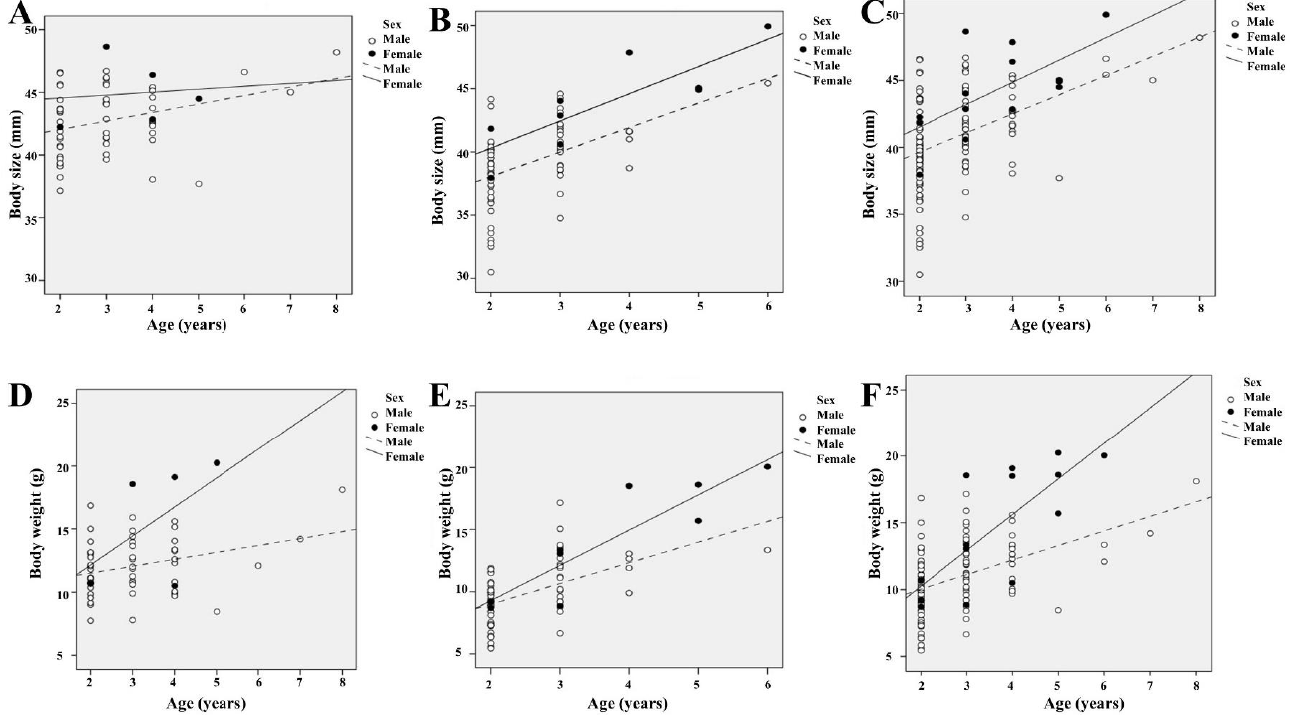
Figure 5. Relationship of age with body size and weight of adult K. borealis population at Lake Sihwa: ( A ) relationship between age and body size in the first year; ( B ) relationship between age and body size in the first year; ( C ) relationship between age and body size in the whole study period; ( D ) relationship between age and body weight in the first year; ( E ) relationship between age and body weight in the first year; ( F ) relationship between age and body weight in the whole study period.